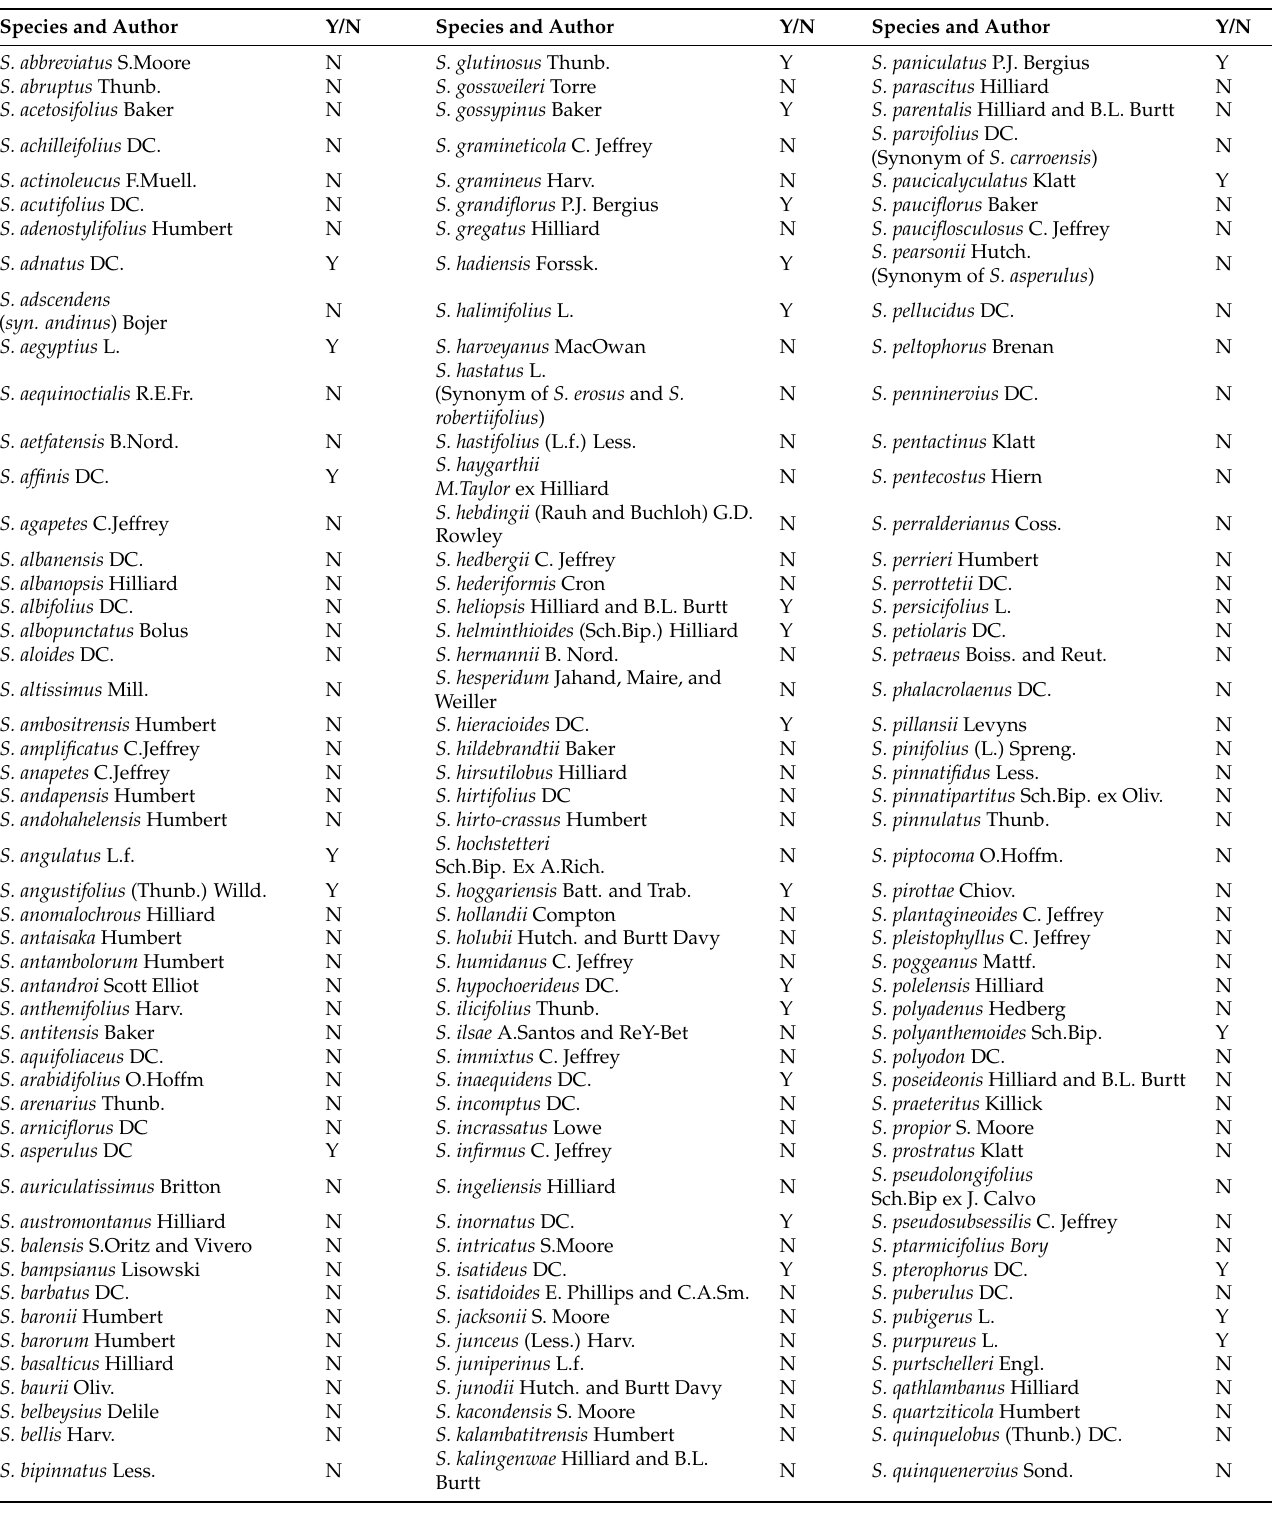
Table 1. A list of all of the currently accepted species of Senecio that are native to Africa, according to POWO (477 species, 469 after synonyms are subtracted), conveying those with phytochemical information and those with no records listed here, as they were not identified in the literature search. Y = phytochemical study found, N = no phytochemical study